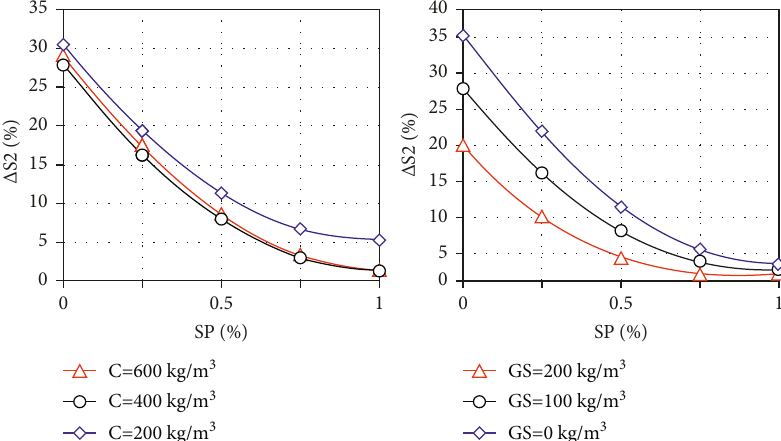
1 is cement consumption, X 2 is SP content, X 3 is slag consumption.